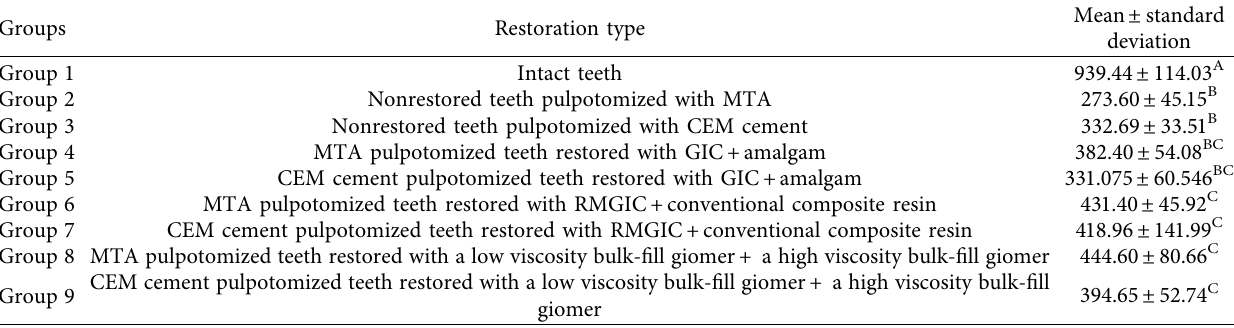
Table 1: The mean fracture resistances (N) and standard deviations of the experimental groups. Groups